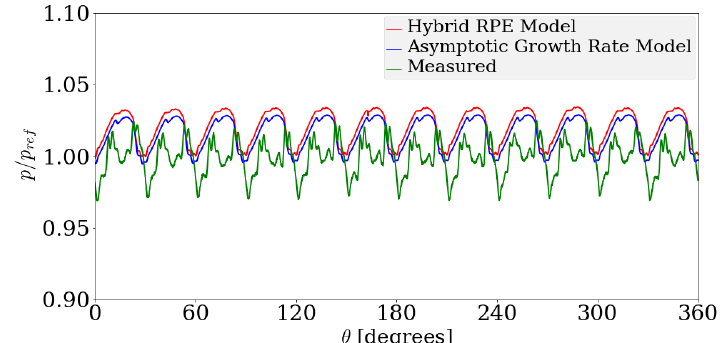
Figure 19. Comparison between delivery pressure ripple for the Asymptotic Growth Rate model, the Hybrid Rayleigh–Plesset Solution approach with experimental data, for an operating speed of 1000 rpm and a suction pressure of − 0.06 bar gauge pressure. The modeled pressure fluctuations are within +3.5% and − 0.2% while the measured data is within +2.5% and − 3.1% of the reference value.